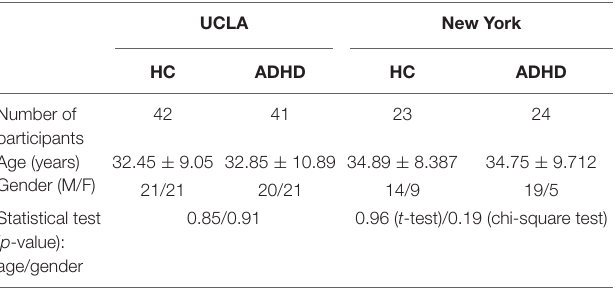
TABLE 1 | Age and gender indices of two independent